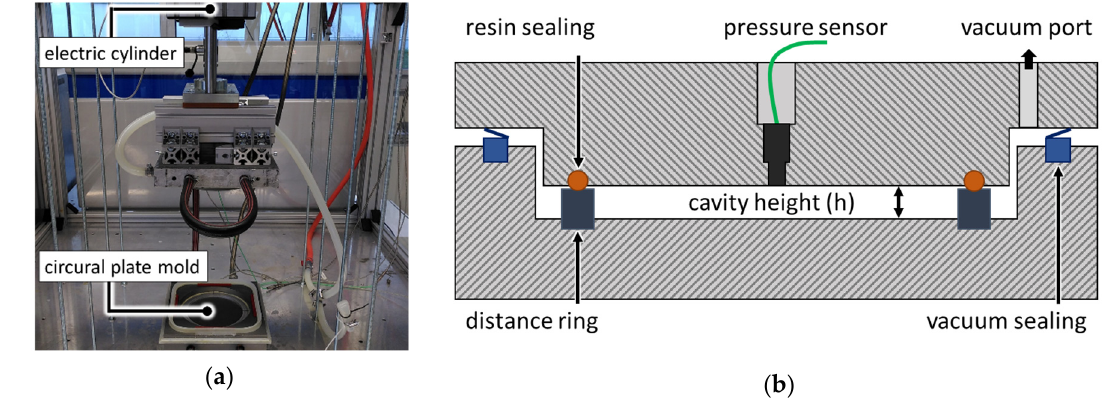
Figure 2. ( a ) experimental setup for D-SCM sandwich manufacturing, ( b ) schematic cross section of the circular plate